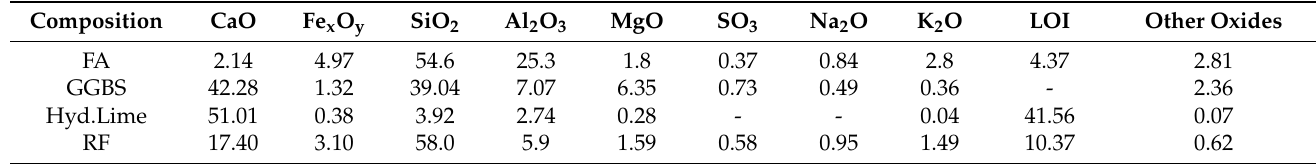
Table 1. Chemical composition of fly ash, granulated blast furnace slag, hydrated lime, and recycled fines. Composition